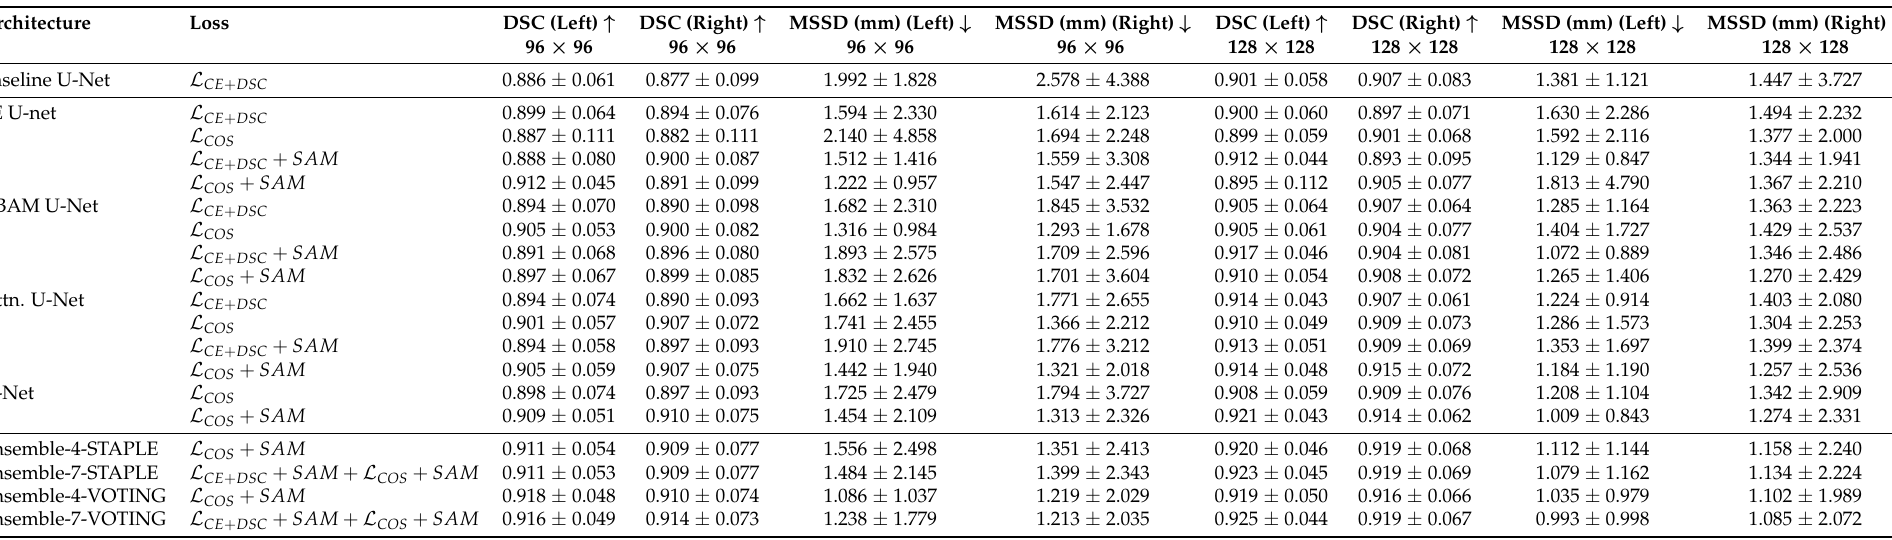
Table A1. The DSC and MSSD (in mm) values for left and right kidneys for various networks and ensembles with loss functions as DSC ( L DSC ), cross-entropy+DSC ( L CE + DSC ), and cosine loss ( L COS ). The results are post-processed using the largest connected